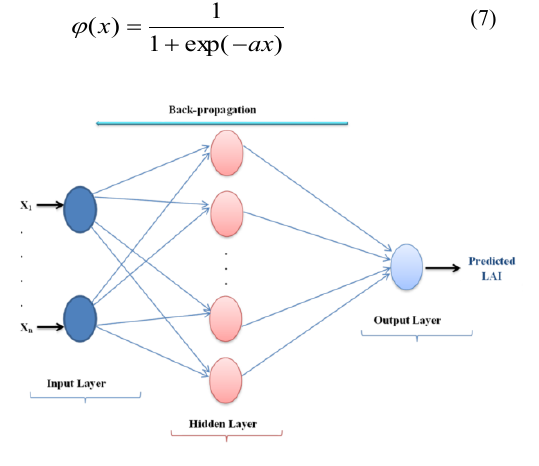
Figure 4.ANNR prediction algorithms